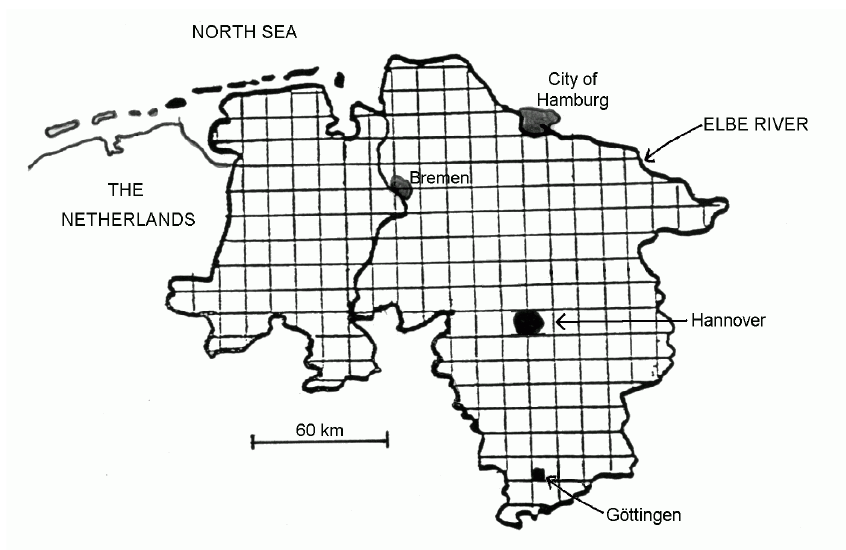
FIGURE 5. Map of the state of Niedersachsen (Lower Saxony) in northern Germany, covered with a soil nitrogen assessment grid as used in the period from 1985 to